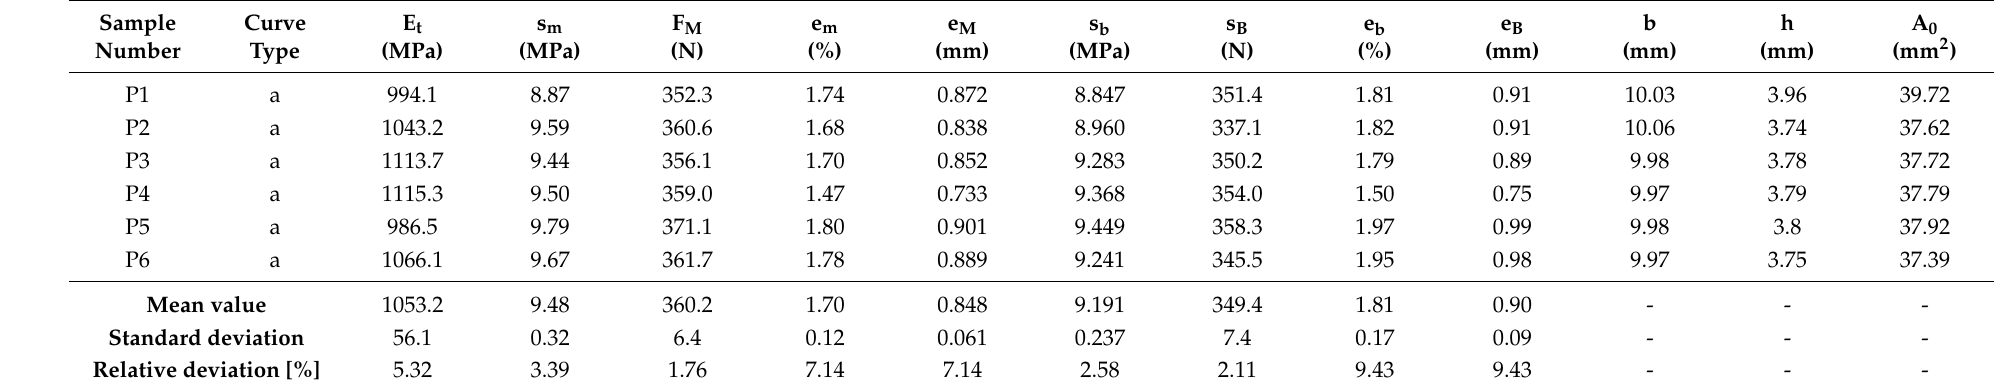
Table A38. Results of the tensile tests of PO_A.